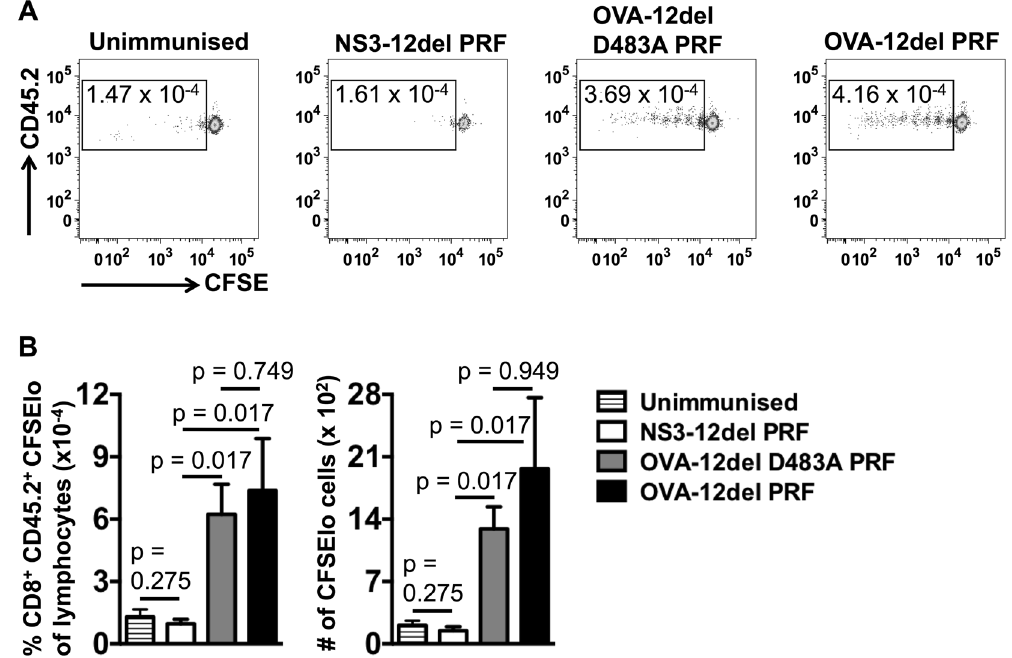
Figure 2. The effect of cytolytic DNA immunisation on early phases of antigen presentation to CD8 + T cells in vivo . ( A ) C57BL/6.SJL (CD45.1 + , CD45.2 − ) recipient mice were immunised via the ID route with 100 μ g of NS3-12del PRF (n = 3), OVA-12del D483A PRF (n = 7), OVA-12del PRF (n = 7) or were unimmunised (n = 3). Four days later, 5 × 10 5 C57BL/6 Rag − / − OT-I cells (CD45.2 + ) labelled with 10 μ M CFSE were adoptively transferred (i.v.) into each recipient mouse and proliferation of transferred CD8 + cells in the CLN was monitored 4 days later. Representative dot plots obtained from CLN samples and gated on CD8 + CD45.2 + cells are shown. The numbers in the gates indicate the percentage of lymphocytes that are single cells (doublet discriminated), CD8 + CD45.2 + with reduced levels of CFSE. ( B ) Mean + SEM of the percentages indicated in A (left panel) and the mean + SEM of the absolute number of CD8 + CD45.2 + CFSElo cells (right